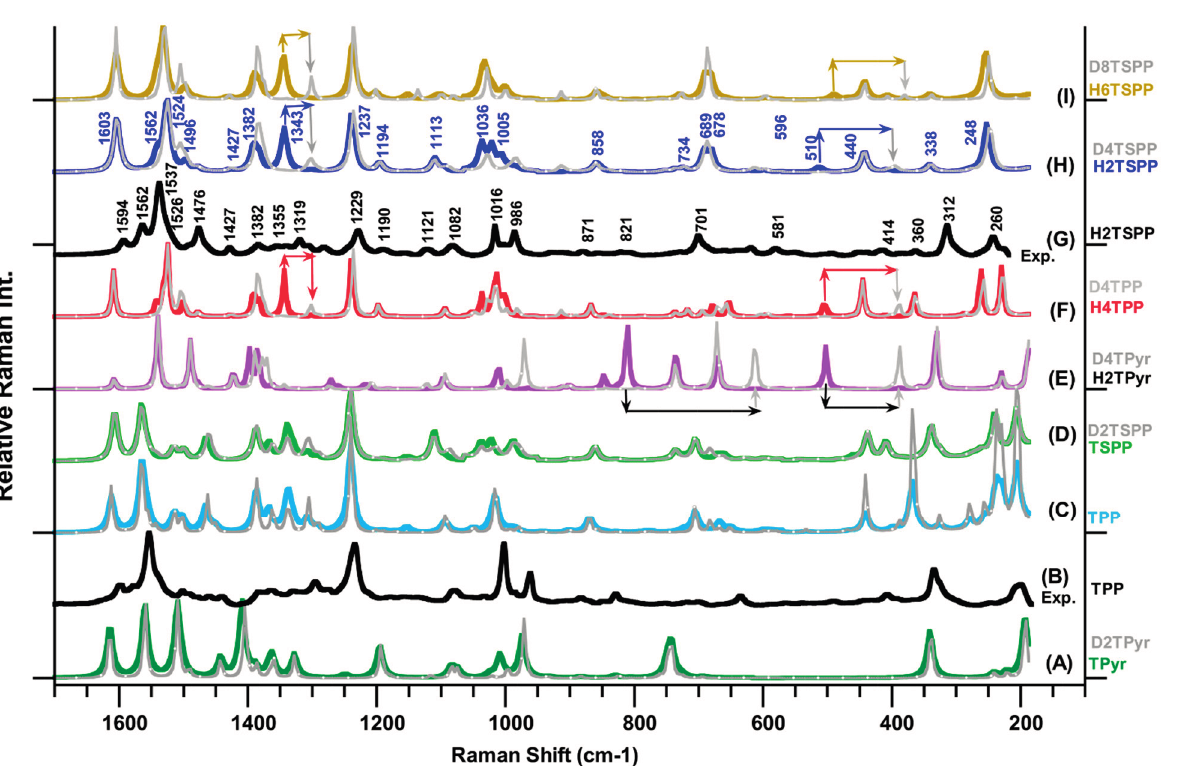
Figure 2. Calculated Raman spectra of porphyrin derivatives in water (used as solvent in the calculations) at the B3LYP/6-311G(d,p) level of the DFT: (A) free-base porphyrin (TPyr) and deuterated-TPyr (D 2 TPyr); (C) meso -tetraphenylporphyrin (TPP) and (D 2 TPP); (D) anionic meso -tetrakis( p -sulfonatophenyl)porphyrin (TSPP) and deuterated-TSPP (D 2 TSPP), and (E) protonated-TPyr (H 2 TPyr) and deuterated-H 2 TPyr (D 4 TPyr); (F) protonated-TPP (H 2 TPP) and deuterated-H 2 TPP (D 4 TPP); (H) protonated TSPP (H 2 TSPP) and deuterated-H 2 TSPP (D 4 TSPP); and (I) dicationic TSPP (H 6 TSPP) and deuterated-H 6 TSPP (D 8 TSPP). The measured Raman spectra of: (B) TPP (taken from ref. [23]) and (G) H 2 TSPP. It should be noted that the plot Raman spectra in the gray color belong to the deuterated molecules, and the line arrows show the frequency shift in the deuterated molecule.